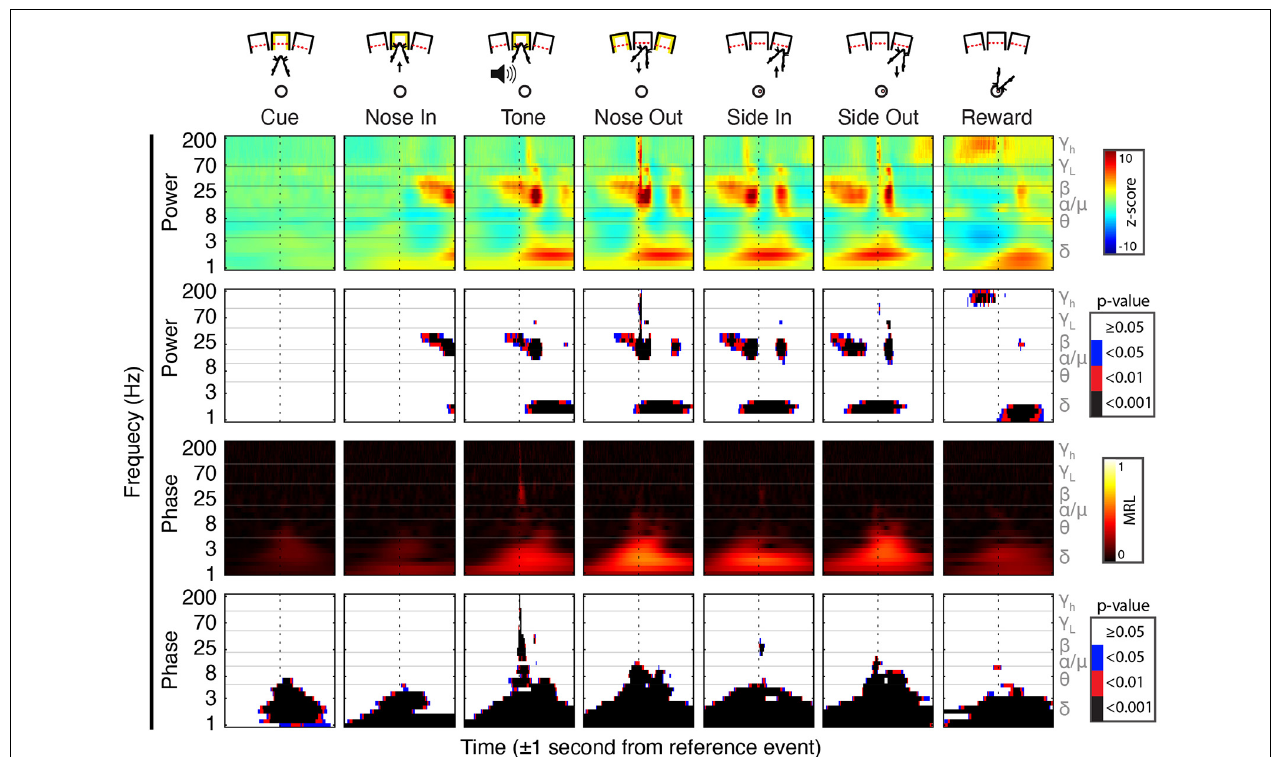
FIGURE 2 | Peri-event field potential (FP) power and phase modulation. (Top Row) Behavioral schematic for a rightward-cued successful trial. (Second Row) Mean Gabor spectrograms for each event for all 30 sessions ( n = 5 rats). (Third Row) P -values for the comparison of peri-event Z-scored power to the session-wide mean of Z-scored power. (Fourth Row) Mean resultant length (MRL) of event-locked FP phase. Higher values indicate time-frequency points at which the FP phase tends to be aligned across trials. (Bottom Row) Significance of peri-event phase alignment compared to the null hypothesis that phase is uniformly distributed at each peri-event time-frequency point.